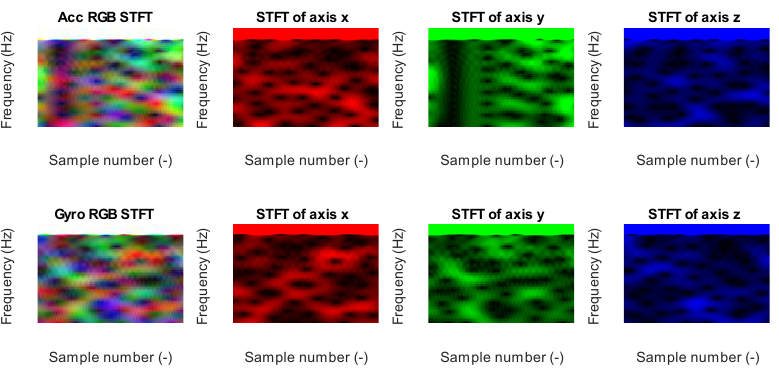
Figure 17. STFT RGB image of idle class for accelerometer x , y , and z axis ( top ) and gyroscope x , y , and z ( bottom ).